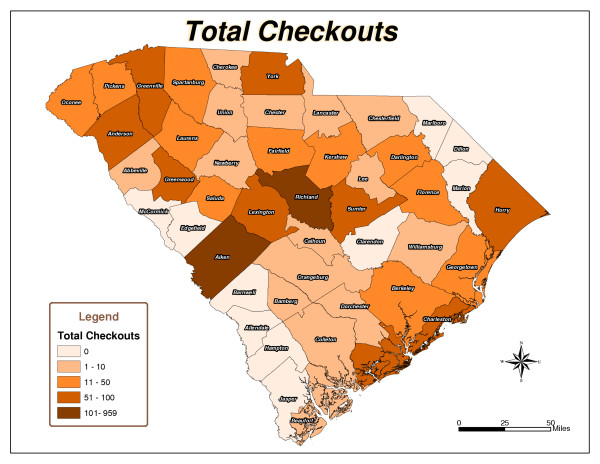
Total Checkouts.